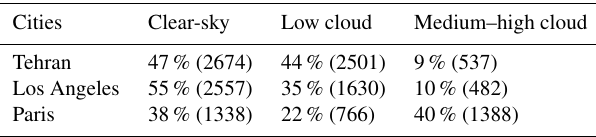
Table 2. Number of clear-sky and cloud-contaminated measure- ments for the cities Tehran, Paris and Los Angeles. The absolute number of observations are given in